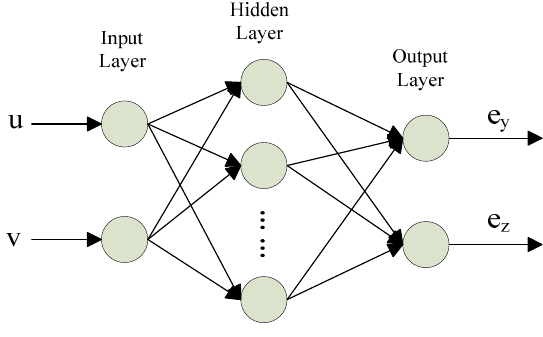
Figure 8. Architecture of the designed MLPNN.